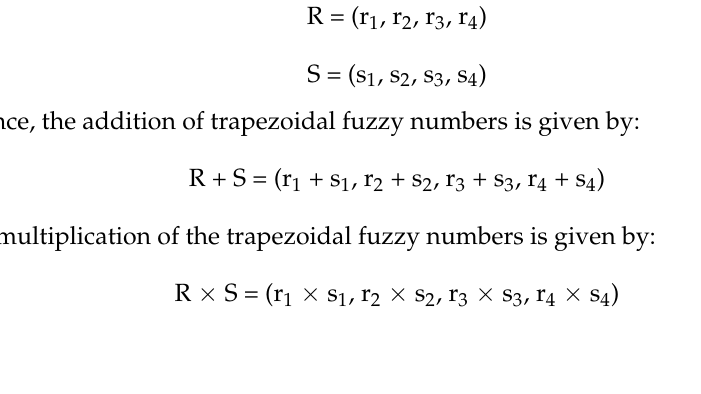
Table 3. Fuzzy IF- THEN α rules .